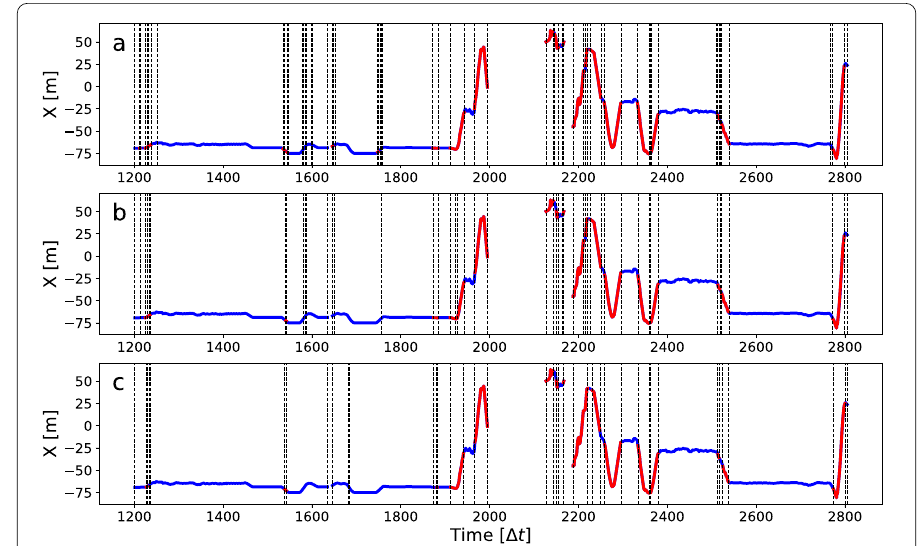
Figure 13 Example track x -coordinate 1D time series, together with the behavioural state estimation, using threshold parameter values ( a ) σ 2 = 1, ( b ) σ 2 = 6, ( c ) σ 2 = 36 (unit = (cid:2) t = 10 s). Red segments are estimated as being in the moving state, and blue segments are non-moving. The dotted vertical lines represent the boundaries between the segments